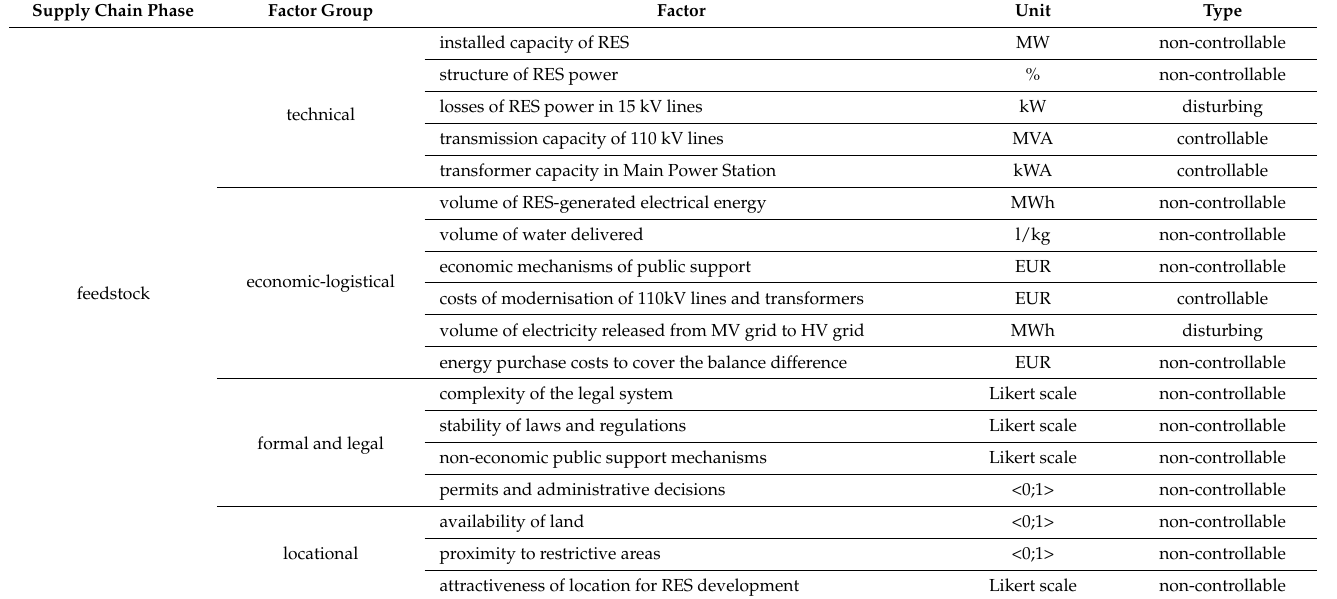
Table 2. Conceptualization of variables in the structural model of the system stabilizing the operation of electric power distribution networks on the basis of a hydrogen energy